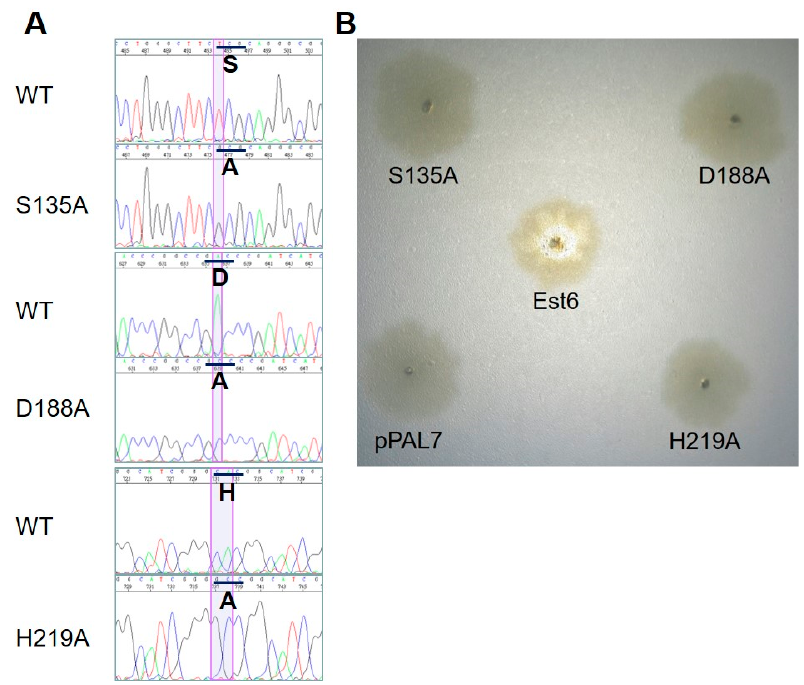
Figure 5. Site-directed mutagenesis of the predicted catalytic triad of Est6. ( A ) DNA sequencing of the predicted catalytic triad regions of wild type and related mutants. The codons and amino acids are shown in underscore and bold form, respectively. ( B ) Lipolytic plate assay for the wild type and related mutants. Mutant colonies show no clear halos compared with the wild type Est6. The transformant harboring the expression vector pPAL7 is the negative control.